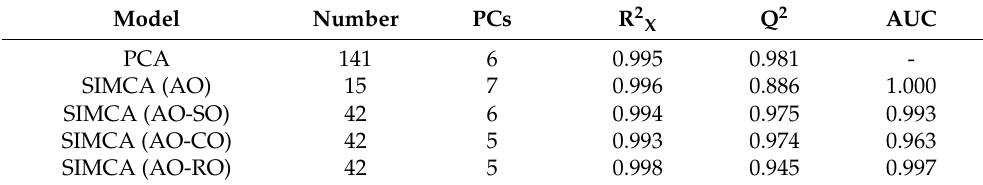
Table 1. The model parameters of PCA and SIMCA.